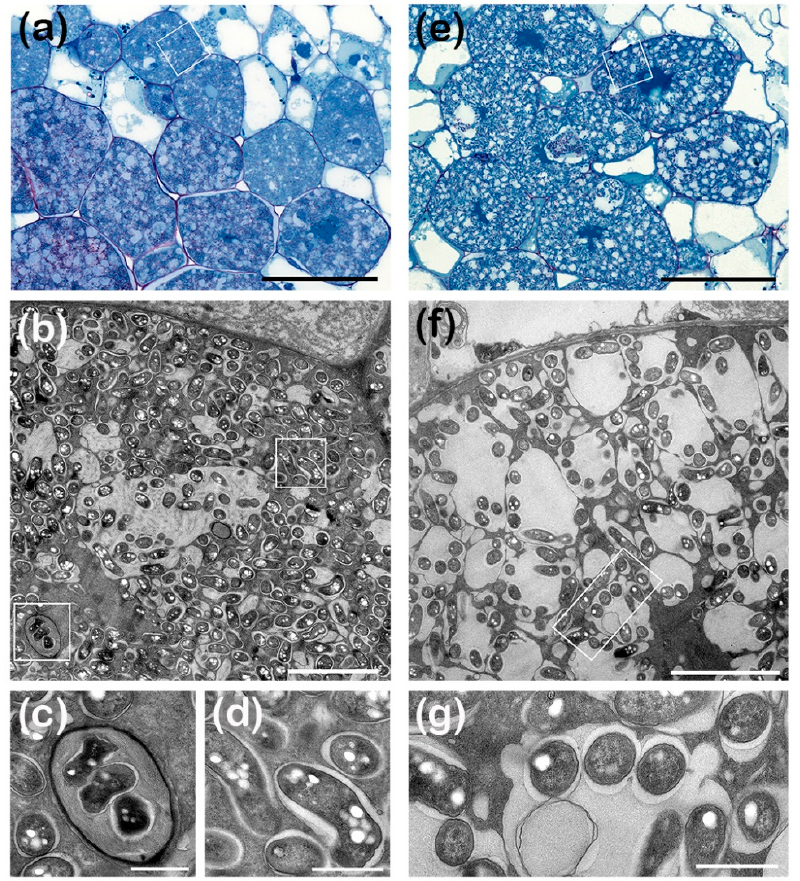
Figure 3. ANU265::pMiniSym2 formed persistent intracellular colonies in L. leucocephala . Micrographs of nodules harvested at 21 days post-infection with NGR234 in panels ( a – d ) and ANU265::pMiniSym2 in panels ( e – g ). Light micrographs ( a , e ) were of 500-nm thick sections whereas electron micrographs were of 85 nm thick sections of the same nodules. Sectors observed at higher magnifications are framed in white rectangles, with for example panels ( c , d ) corresponding to magnified areas of the nodule cell shown in ( b ). Higher magnification of NGR234 ( d ) and ANU265::pMiniSym2 ( g ) intracellular nodule bacteria. ( c ), cross section of one transcellular infection-thread. Poly - β -hydroxybutyrate (PHB) seen as electron-transparent droplets in bacteria. More than six nodules collected on several roots were processed per treatment. Scale bars are 50 µ m in ( a , e ), 5 µ m in ( b , f ) and 1 µ m in panels ( c , d , g